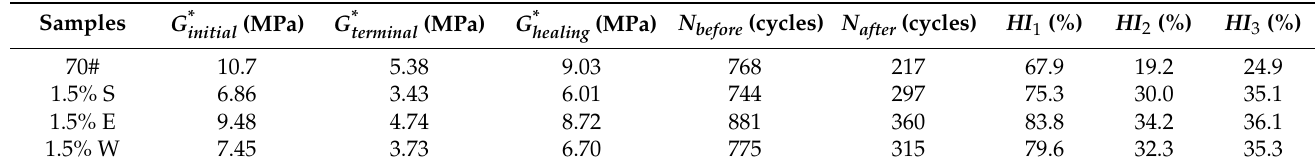
Figure 12. Fatigue–healing–fatigue test results of the asphalt containing the different healing agents. Table 3. Performance restoration of the asphalt with different kinds of healing agents.